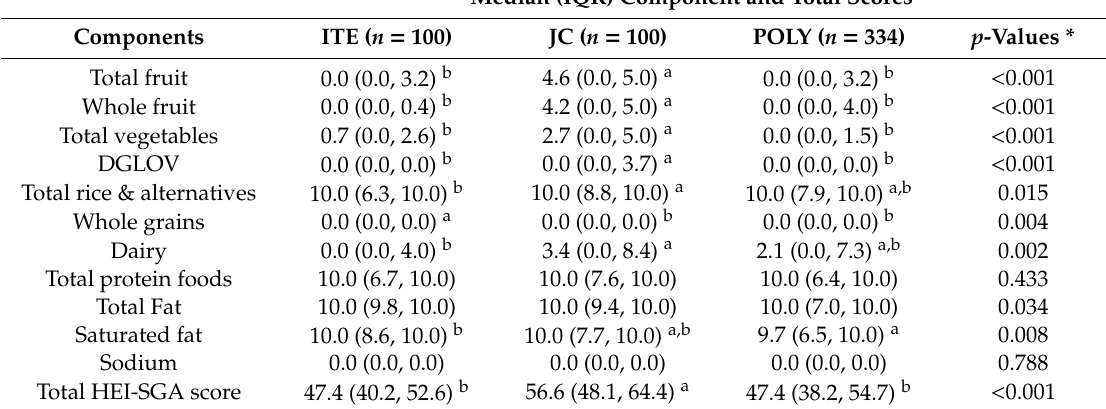
Table 5. Median component and total HEI-SGA values in Singaporean students attending di ff erent educational